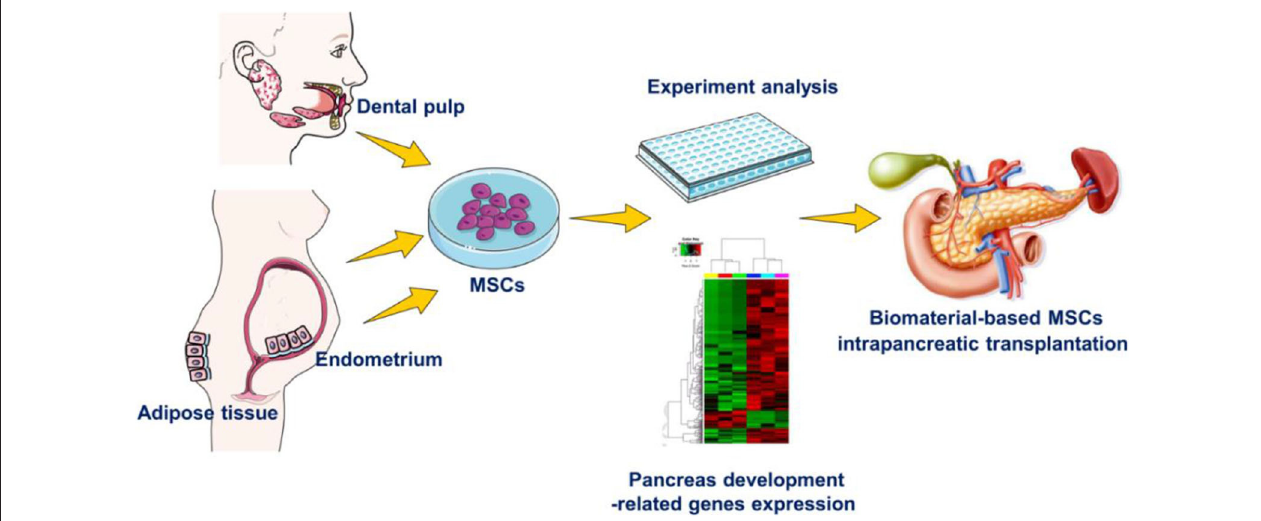
FIGURE 1 | Experimental design. The differences in hEnSCs, hDPSCs and hADSCs in the aspects of biological characteristics in vitro and their survival situation with Matrigel biomaterial post intrapancreatic transplantation in vivo .